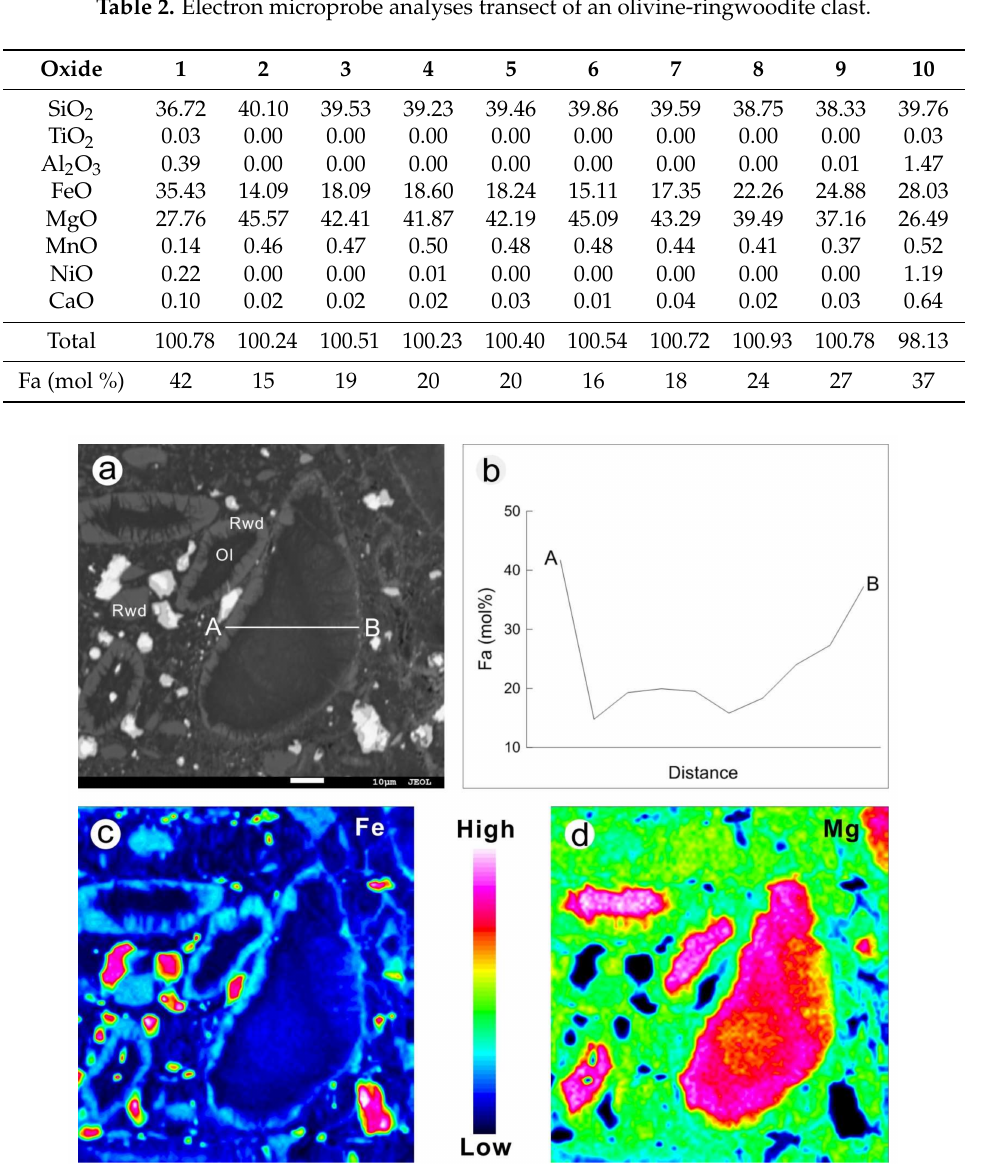
Figure 5. ( a ) A BSE image of four olivine-ringwoodite clasts with a rim of ringwoodite and a core of olivine + ringwoodite. ( b ) Fa content profile of an olivine-ringwoodite clast. The location measured A-B profile is shown in ( a ). ( c , d ) Electron microprobe X-ray elemental maps of iron (Fe) and magnesium (Mg), respectively. Rwd—ringwoodite,